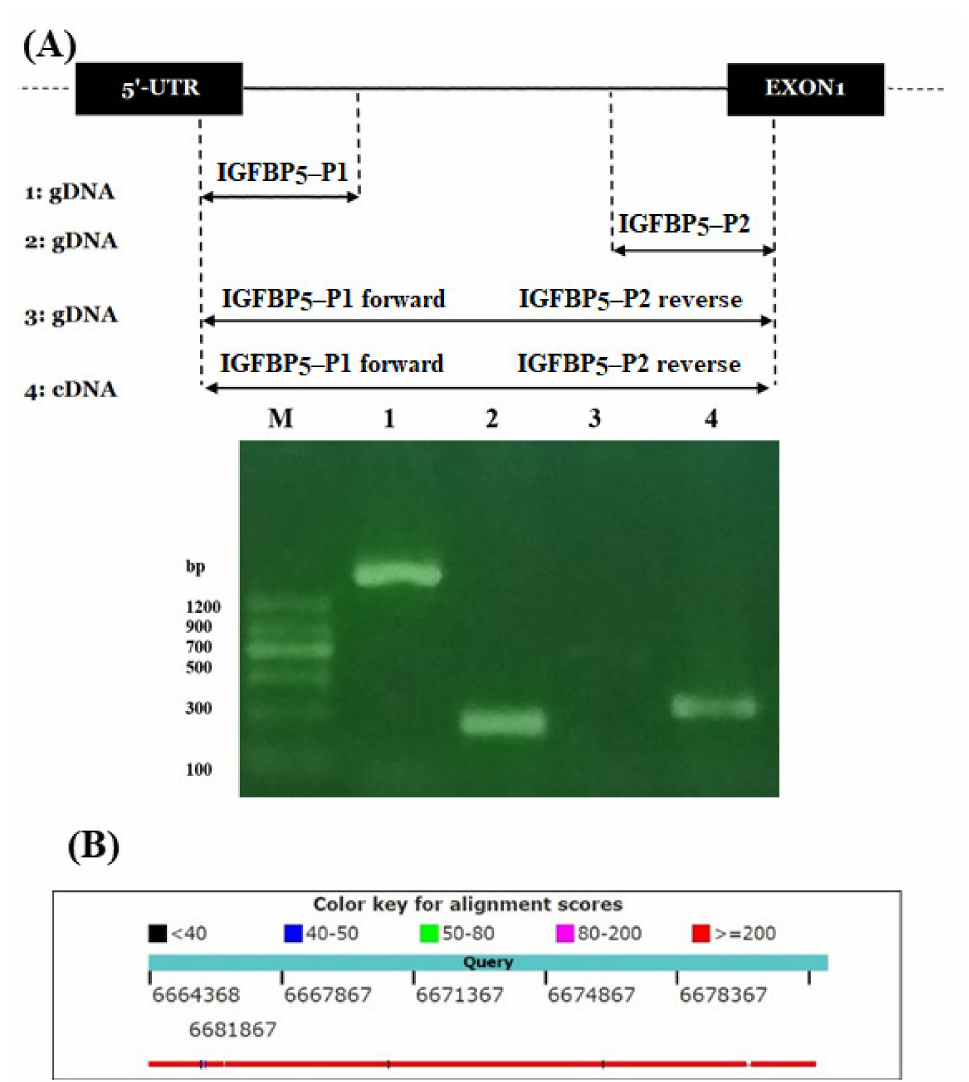
Figure 4. Amplification and validation of the missing sequence between the 5 (cid:48) -UTR and exon 1 of the goose IGFBP5 gene ( A ) and the alignment of complete genomic sequence of the goose IGFBP5 gene against the duck IGFBP5 gene ( B ). ( A ) Schematic illustration of the locations of gene-specific primers ( IGFBP5 -P1/2) over the goose IGFBP5 gene for amplifying and confirming the missing intronic sequence between the 5 (cid:48) -UTR and the first exon. In the scheme, the labels “1: gDNA, 2: gDNA, 3: gDNA, 4: cDNA” denote the DNA templates used in the PCR with their corresponding primers indicated above the arrow lines. The PCR products were separated on agarose gel by electrophoresis, which is shown in the image with Lanes 1 to 4, corresponding to the labels mentioned above. M, DNA marker. ( B ) The alignment indicates that the goose genomic sequence of the goose IGFBP5 gene highly matched the duck IGFBP5